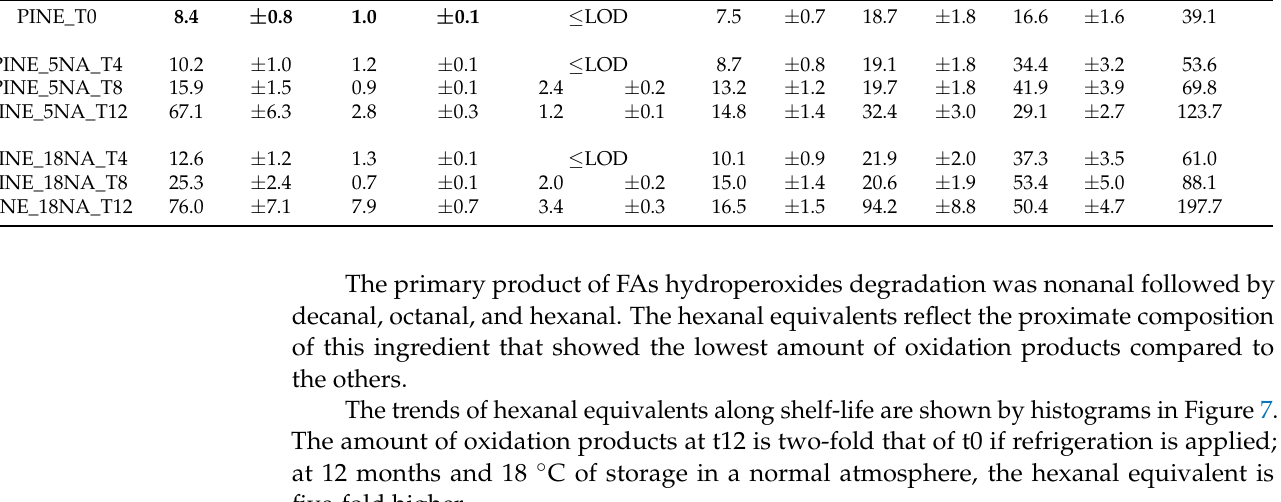
Table 6. Amounts expressed as ng/g for quantified targeted aldehydes in dried pineapple samples. In bold analytes whose concentration exceeds the OTs (OAV >